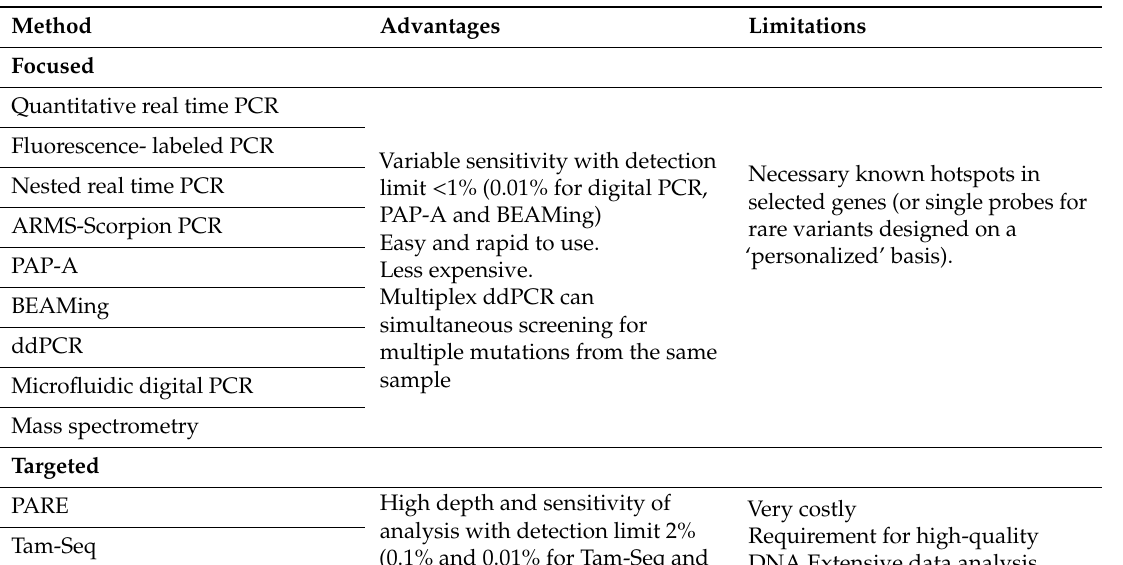
Table 1. Most common methods used to detect circulating tumor DNA (ctDNA) and analyse plasma androgen receptor (AR)